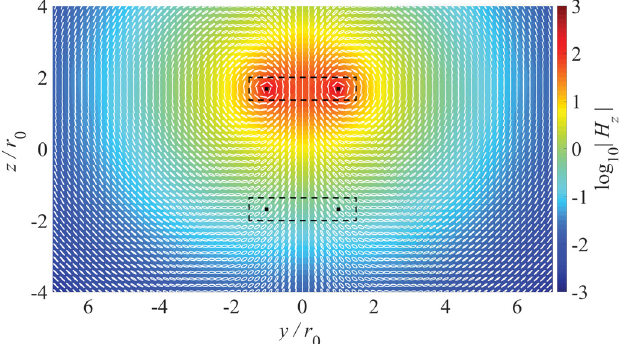
Fig. 7. Polarisation ellipses and magnitude of the magnetic fi eld produced by a transmitter coil of radius of r 0 ¼ 11mm when a coaxial receiver coil displaced by 37 mm, and two coils are insulated by two cylindrical dielectric boxes with the height 2 h = 7mm. Ellipse axes are normalised and plotted at a sampling step of 2mm along the y and z directions. Black dash lines mark the cross sections of the dielectric boxes. The conductivity of the block is s =10S/m. The mutual inductances is M =0.11 ∠ (cid:2) 122 ° .